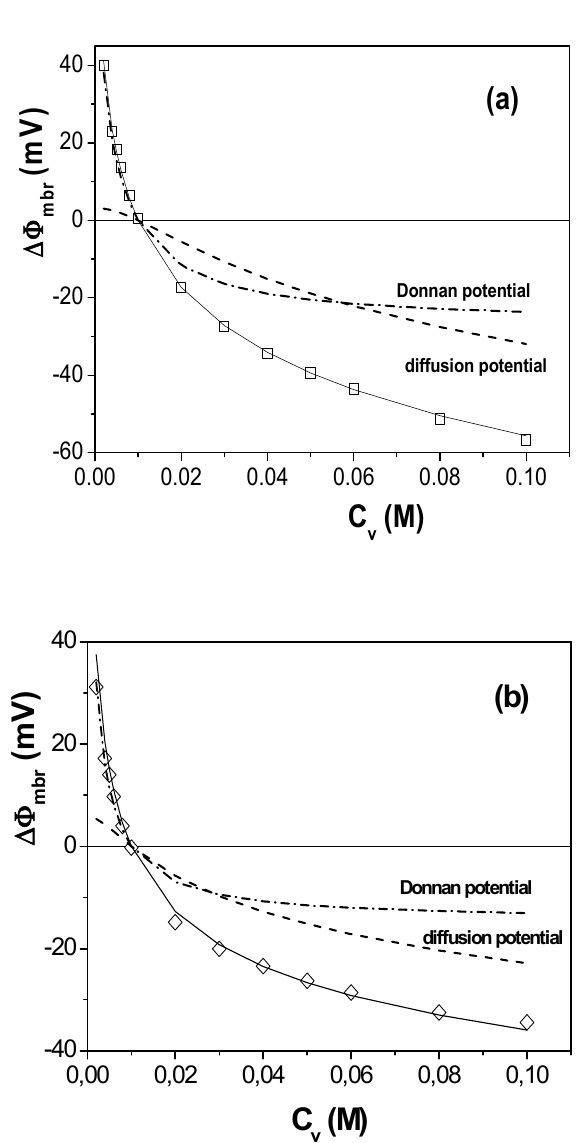
Figure 4. Membrane potential as a function of variable solution C v . ( a ) Sf-NPAM/TiO 2 membrane ( □ ) experimental values and ( b ) Ox-NPAM/TiO 2 membrane ( ◊ ) experimental values, fitted values (solid line), diffusion potential contribution (dashed line) and Donnan potential contribution (dashed dot line). Fitted values: (a) X ef = +0.015 M, t Cl − /t Na + = 3.74; ( b ) X ef = +0.012 M, t Cl − /t Na + = 2.47.